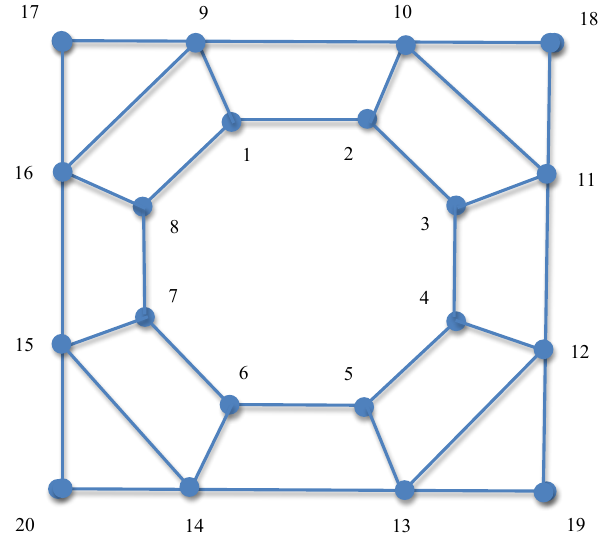
Figure 4. Genetic Matching Graph: There are 20 nodes in the graph, with node i representing allele i , i = 1, . . . ,20. If allele i and j make a successful genotype, there is a link between node i and j